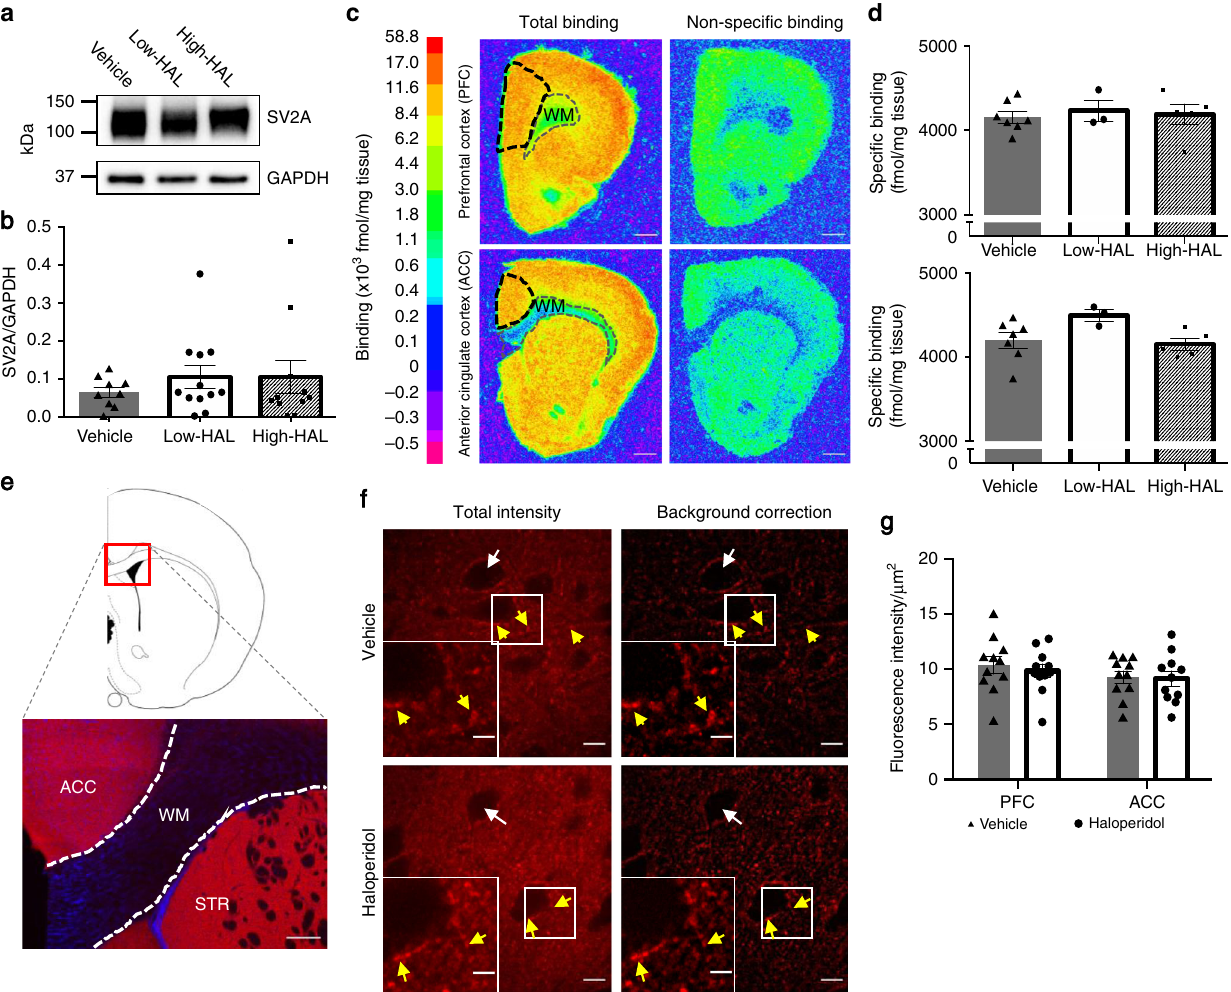
Fig. 4 Chronic haloperidol administration does not affect SV2A levels in the rat frontal cortex (FC). a Example of western blots showing total SV2A levels in synaptosomes isolated from the FC. b Quanti fi cation of total SV2A levels on western blot, normalised to GAPDH, showed no signi fi cant changes upon chronic haloperidol treatment (Kruskal – Wallis test, p = 0.71). c Autoradiography images of brain sections incubated with 12.5 nM [ 3 H]UCB-J in absence (left) or presence (right) of levetiracetam (a drug that binds to SV2A). Black boxes indicate which ROI was selected to measure tracer binding in the prefrontal cortex, PFC (top), or anterior cingulate cortex, ACC (bottom). WM, white matter. Colour bar indicates [ 3 H]UCB-J binding levels. Scale bar, 1 mm d Quanti fi cation of [ 3 H]UCB-J binding in PFC (top) and ACC (bottom), indicating no signi fi cant changes upon chronic haloperidol treatment (two- way ANOVA, F 2,12 = 1.451, p = 0.27). e Top: schematic of brain section at Bregma 1.1 mm. Bottom: low magni fi cation fl uorescent image of a rat brain section immunostained for SV2A (red) and DAPI (blue). Scale bar, 250 µ m. ACC, anterior cingulate cortex; WM, white matter; STR, striatum. f High- magni fi cation confocal images of brain sections from vehicle- (top) or haloperidol- (bottom) treated animals, showing punctate immunostaining for SV2A. Both raw images (left hand side) as well as background corrected images (right hand side) are shown. White arrows indicate a lack of SV2A punctae in the cell body; yellow arrows indicate examples of presynaptic terminals at perisomatic synapses and proximal dendrites. Scale bar, 10 µ m (large fi eld of view) or 4 µ m (zoomed insets). g Quanti fi cation of background corrected SV2A intensity values. There were no signi fi cant differences in SV2A immunostaining intensity between vehicle- and haloperidol-treated groups (two-way ANOVA with Bonferroni ’ s multiple comparison correction, F 1,20 = 0.1412, p = 0.71). Error bars indicate standard error of the